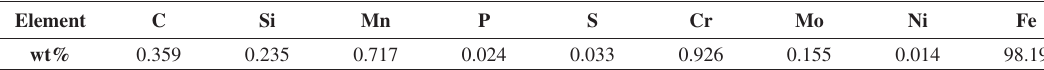
Table 1. Chemical composition of the AISI 4140 steel. Element